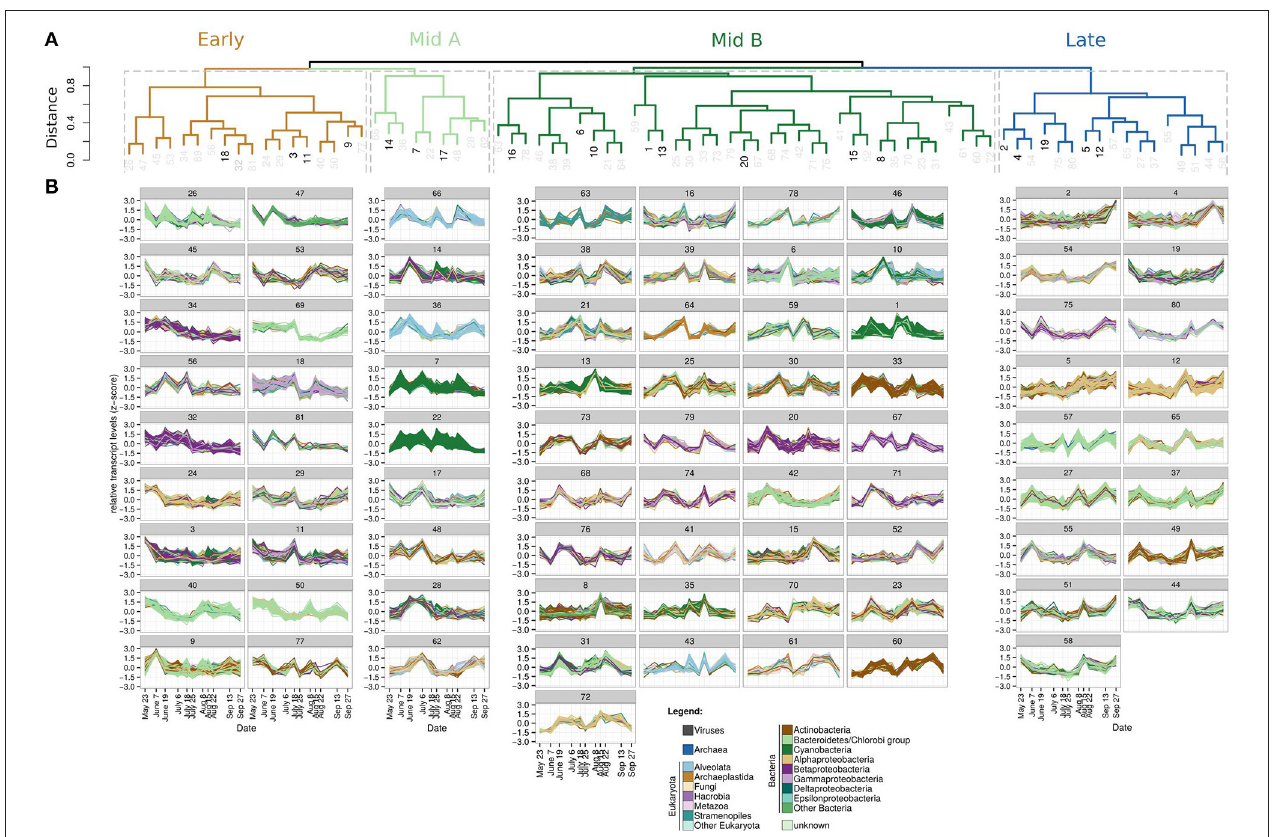
FIGURE 2 | (A) Dendrogram showing the similarities of the 81 eigengenes representing different expression patterns. Dark black numbers indicate the largest clusters from 1 to 20 (as defined by the number of ORFs in each cluster), which are shown in the Hive plots ( Figure 3B ). Taxonomic composition and expression profiles of all 81 clusters are shown in Supplementary Figures 5, 6, respectively. Cutting the dendrogram at 0.95 results in four major groups assigned the names Early, Mid A, Mid B, and Late being congruent with genes that have their expression peaks early, during, and at the end (“Late” component) of the seasonal blooms, respectively. (B) . Z-score transformed expression patterns of all ORFs within the 81 clusters during the 2012 time-series sampled off the island of Askö, Sweden, in the Stockholm archipelago. Each panel shows the expression patterns of all individual ORFs assigned to that cluster (number